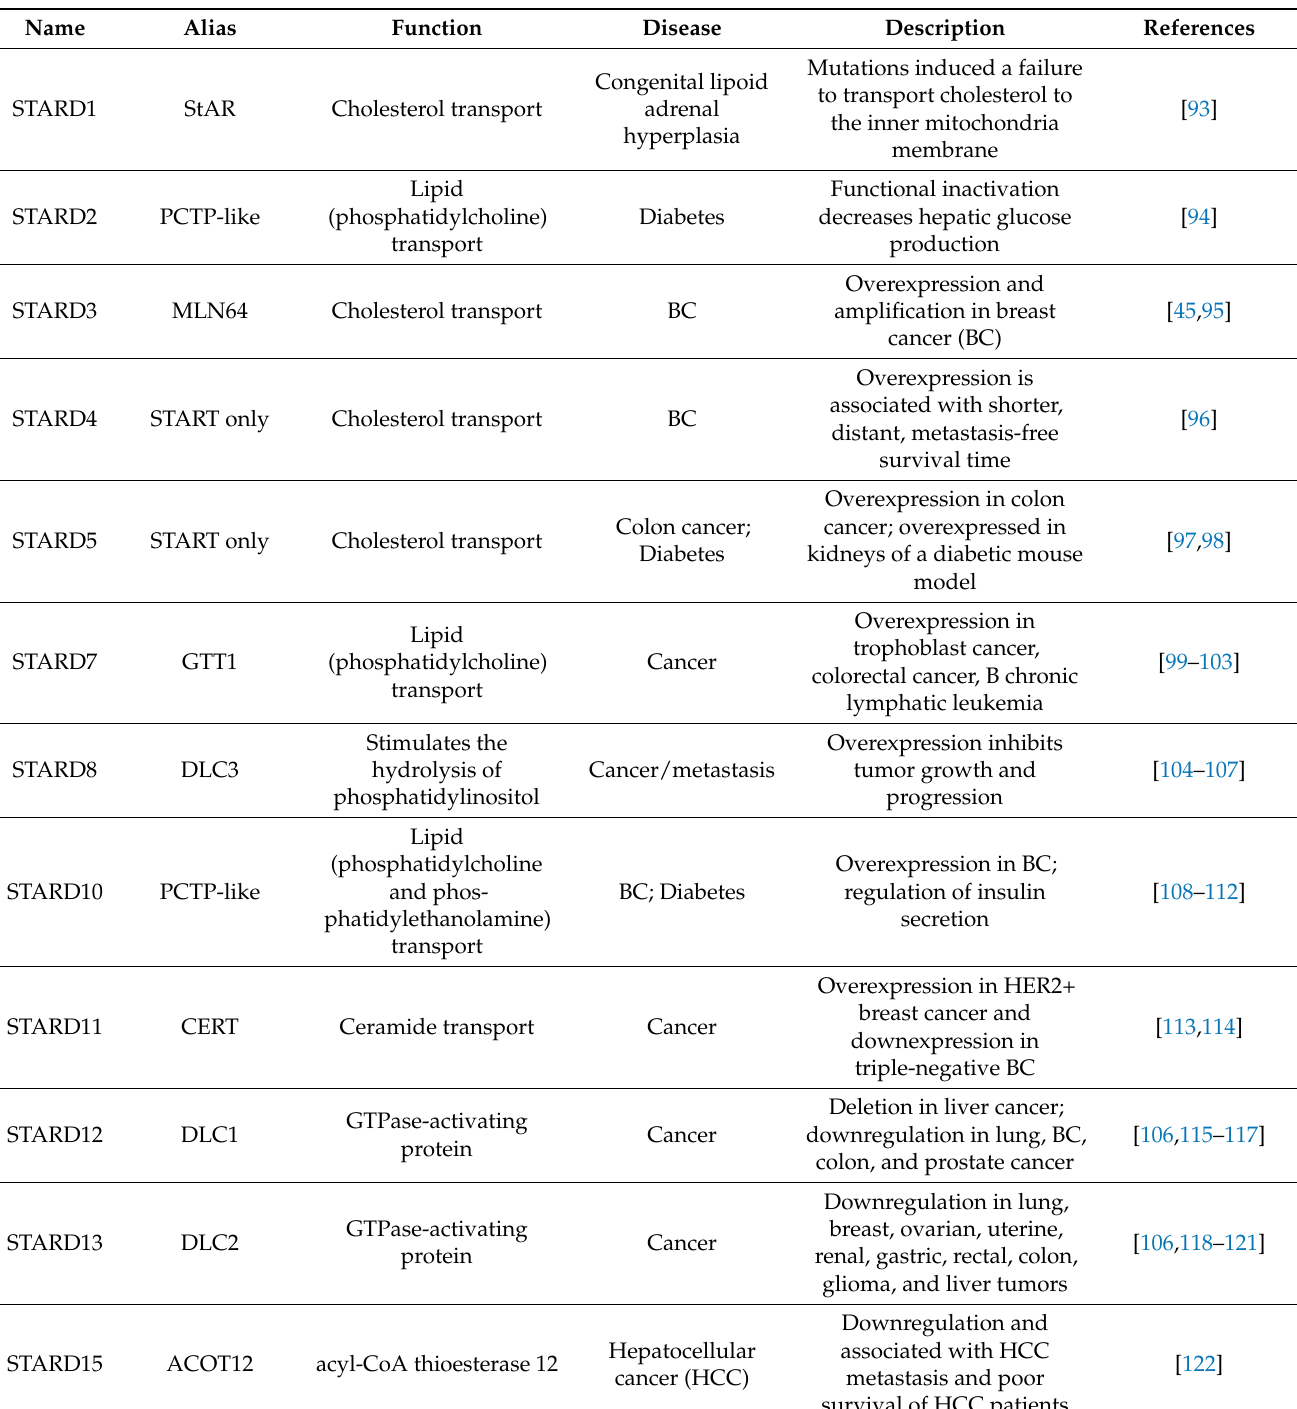
Table 1. Summary of START proteins and their alteration in human